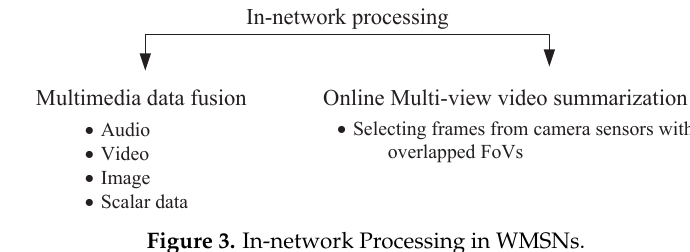
Figure 3. In-network Processing in WMSNs.